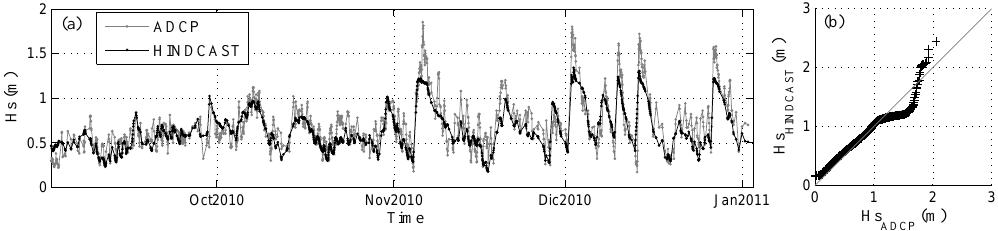
Figure 3. (a) Time series section of observed and hindcast significant wave height and (b) Q–Qplot showing the comparison between ADCP wave data and modeled hindcast data at a location close to the study area. Solid line in (b) indicates perfect